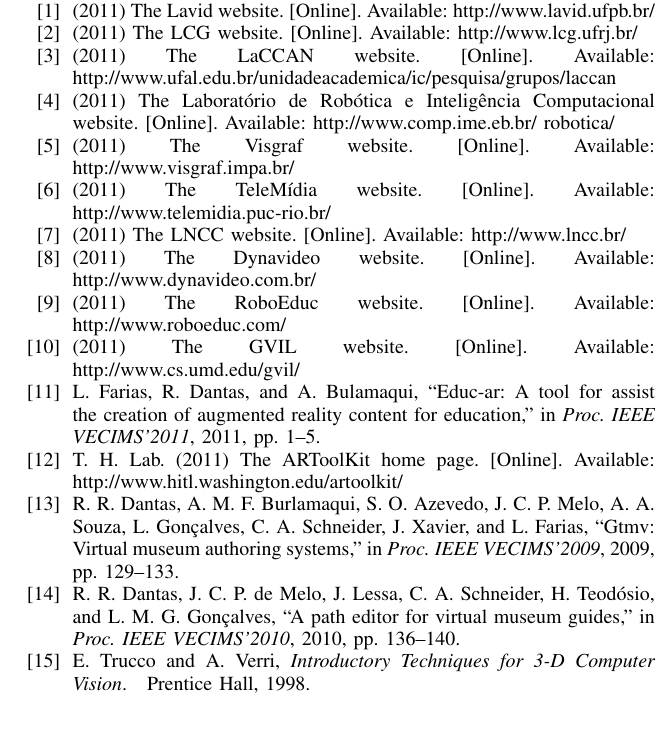
Fig. 6. Results for two different images.